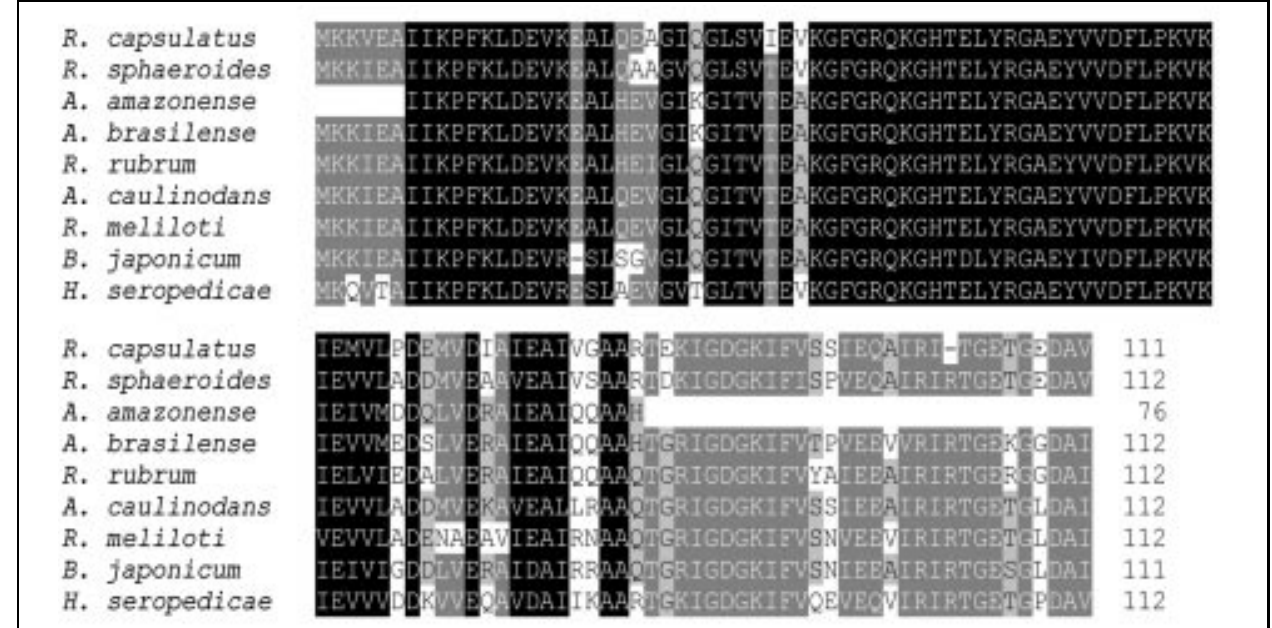
Figure 5. Azospirillum amazonense glnB partial deduced amino acid sequence alignment with A. brasilense (GenBank accession No. X51499), Rhodobacter sphaeroides (GenBank accession No. AF032116), R. capsulatus (GenBank accession No. U25953), Rhodospirillum rubrum (GenBank accession No. X84158), Azorhizobium caulinodans (GenBank accession No. Y10213), Rhizobium meliloti (GenBank accession No. U50385), Bradyrhizobium japonicum (GenBank accession No. M26753), and Herbaspirillum seropedicae (GenBank accession No. U86073) P II proteins. A black background indicates conserved residues in all aligned sequences, a dark grey background indicates conserved residues in at least 80% of the aligned sequences, and a light grey background indicates conserved residues in at least 6% of the aligned sequences. Multiple alignments were done with the PILEUP program, University of Wisconsin Genetics Computer Group, and the alignment editing was done with the GENDOC program considering the Dayhoff PAM 250 score table